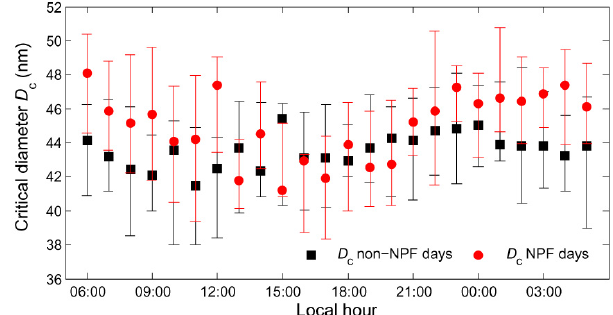
Fig. 10. Diurnal variation of median D c on 29 spring Type I event (red) and 53 spring non-event (black) days. Shown from 06:00UTC + 2 of the day in question until 05:00 of the following day, for S eff of 1.0%. Error bars are 25th and 75th